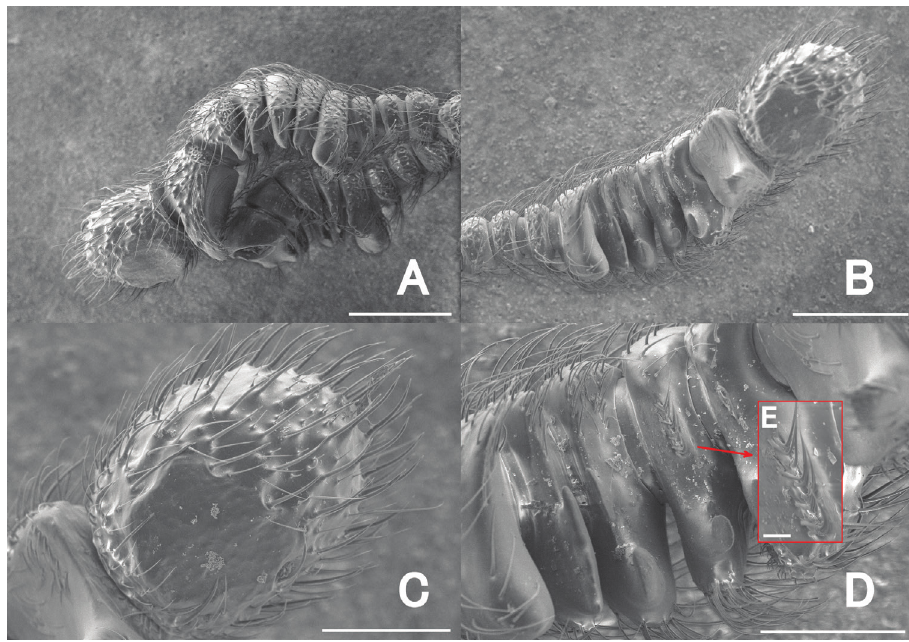
Figure 12. Male antenna of Pseudophanias excavatus by SEM images A lateral view B ventral view C antennomere 11 in ventral view D antennomeres 5–10 in ventral view E special setae on antennomere VIII in ventral view. Scale bars: 0.2 mm ( A, B ); 0.1 mm ( C, D ); 0.01 mm ( E